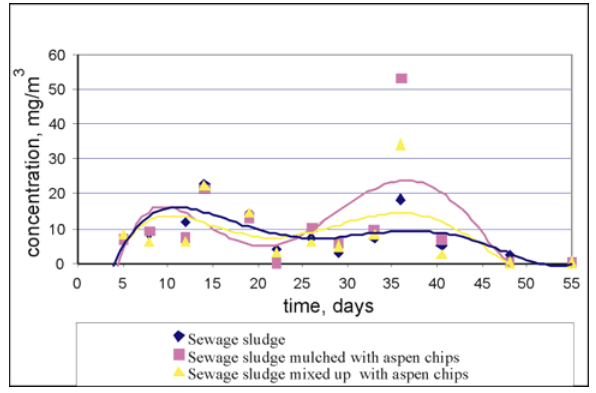
Fig. 18. VOC emissions during composting of sewage sludge with aspen chips